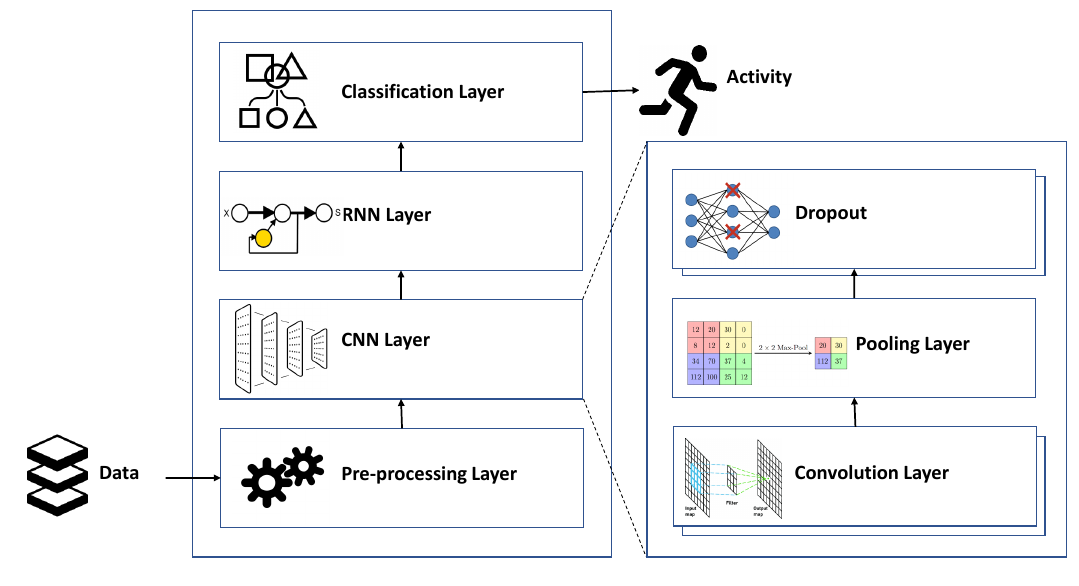
Figure 2. The architecture of the HAR